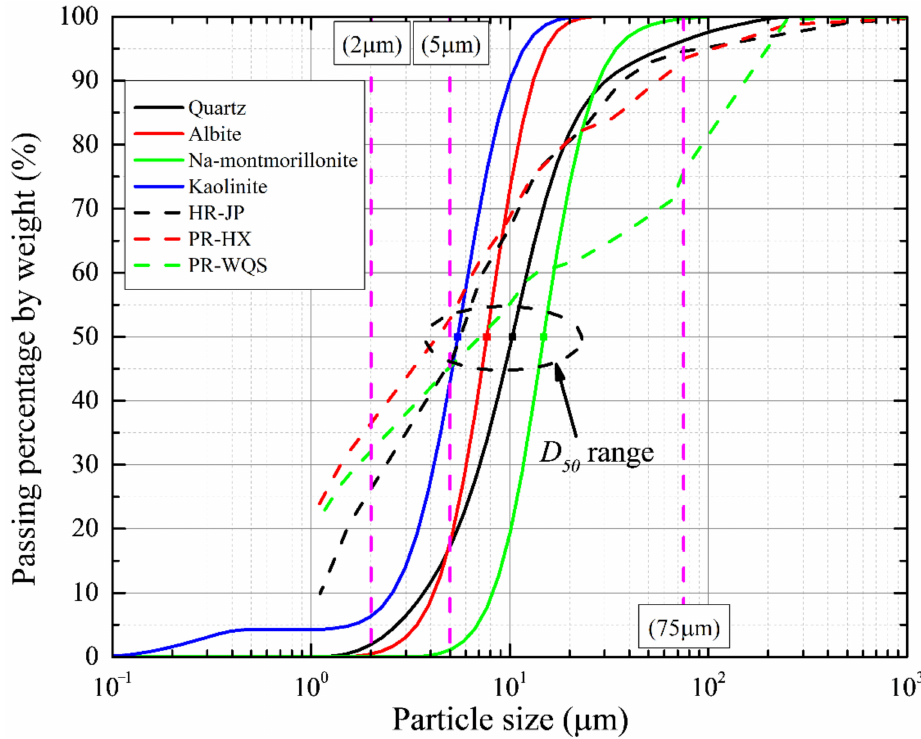
Figure 2. Particle size distribution curve of four types of raw minerals and three types of natural marine